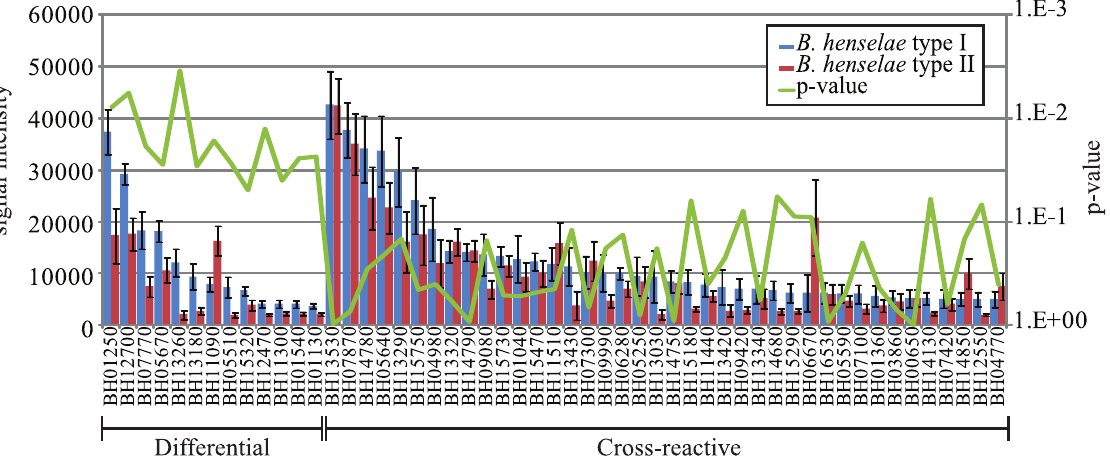
Figure 4. Differential seroreactivity of B.henselae type I and II cats. Mean seroreactivity of B. henselae type I (n=10) and type II (n=14) are plotted in blue and red, respectively. Corresponding SEM and p-values on the secondary y-axis are shown for each antigen. All nine differentially reactive antigens and the 30 most reactive cross-reactive antigens are plotted on the x-axis. Antigens are sorted left to right by decreasing seroreactivity of B. henselae type I infected cats.